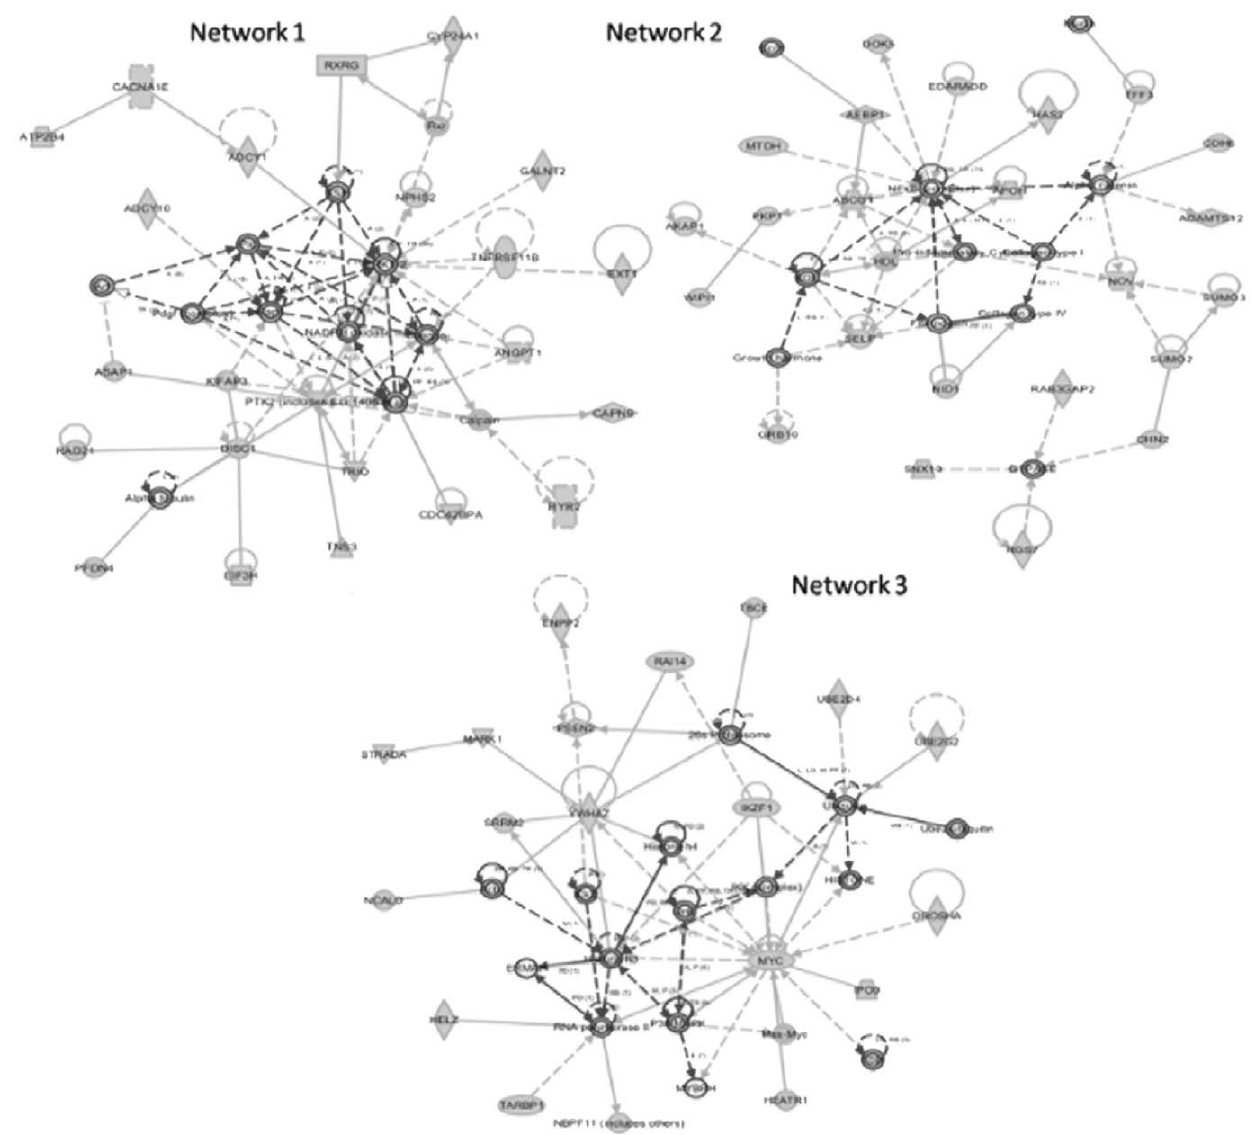
Figure 4. Common Networks: Cellular Movement, Connective Tissue Development and Function, Cellular Assembly and Organization (Network 1), Cell-To-Cell Signaling and Interaction, Tissue Development, Organismal Injury and Abnormalities (Network 2), Cell Morphology, Cellular Assembly and Organization, Cellular Compromise (Network 3).